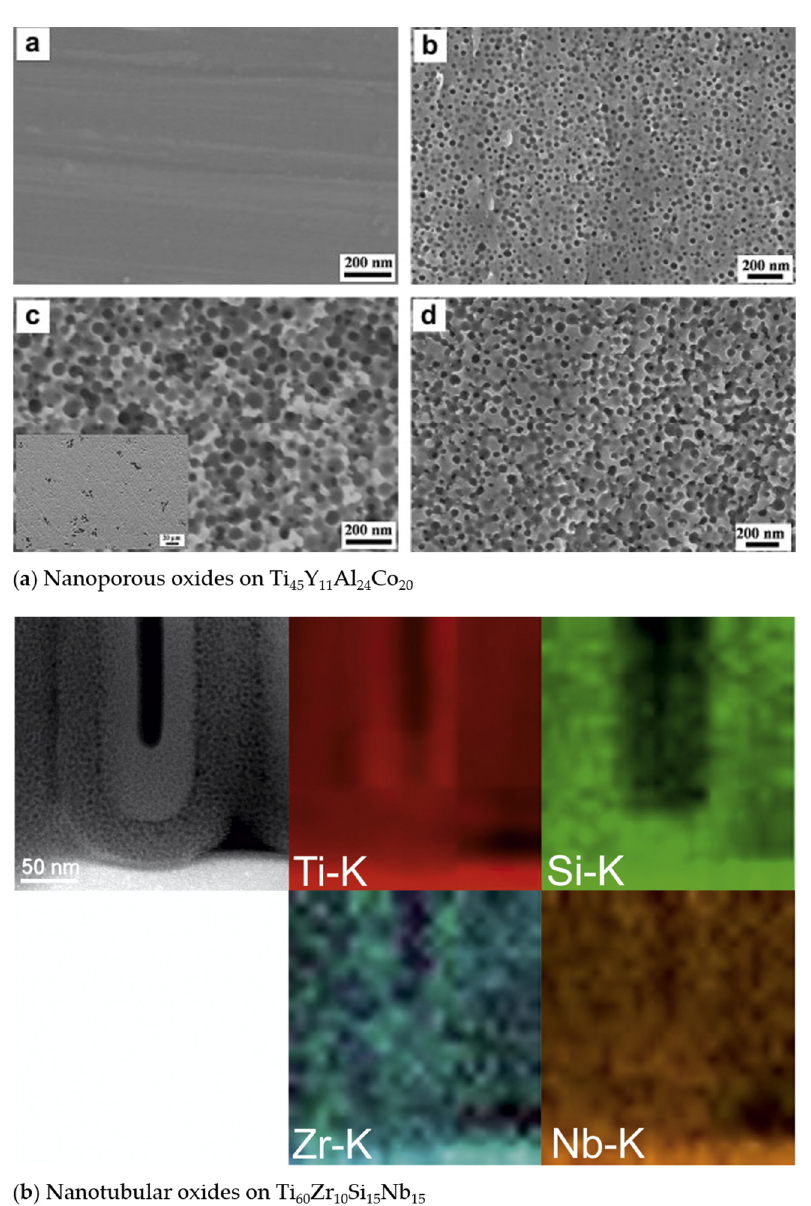
Figure 9. Nanostructured oxide layers grown on glassy alloys: ( a ) nanoporous oxides on a Ti-Y-Al-Co alloy. The electron microscope images show the nanopores formed after various treatments. Reprinted (adapted) with permission from ref. [33]. Copyright 2009 Elsevier Ltd.; ( b ) nanotubular oxides grown on Ti-Zr-Si-Nb alloy. Electron microscope images show the layered tubular structure and the distribution of the different alloying elements in the oxide. Reprinted (adapted) with permission from ref. [53]. Copyright 2016 Elsevier B.V.